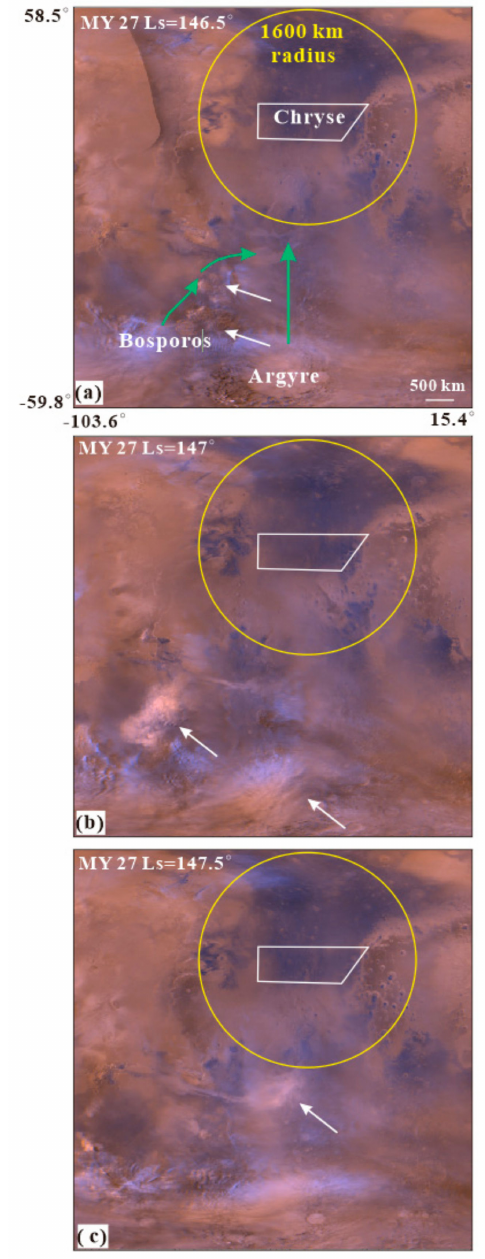
Figure 6. The dust storm activity of the southern hemisphere (Argyre and Bosporos) in northern summer season (Ls = 135–160 ◦ ) within the monitoring area of Chryse. ( a – c ) are MOC MDGMs at Ls = 146.5–147.5 ◦ of MY 27, a simple cylindrical projection with a resolution of 6 km/pixel. The white and green arrows denote the dust storm events and the southern dust storm sequences [11], respec- tively. The white polygon and yellow circle represent the Chryse landing area and its 1600 km-radius monitoring